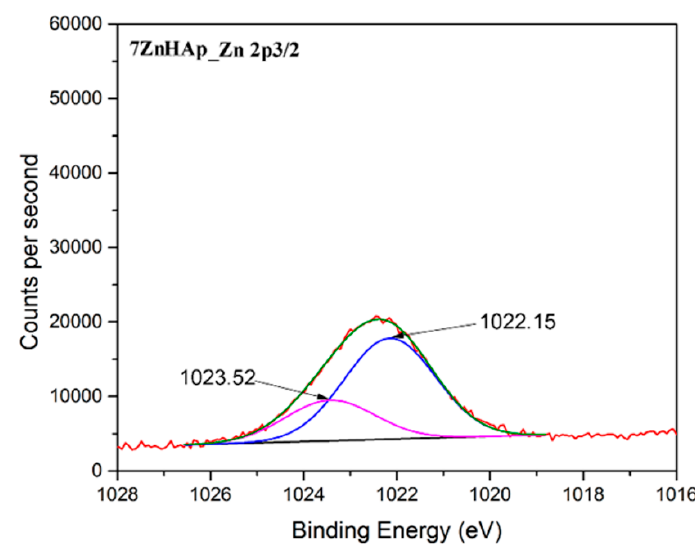
Figure 7. The high-resolution XPS spectrum for Zn 2p of and 7HApZnsamples.